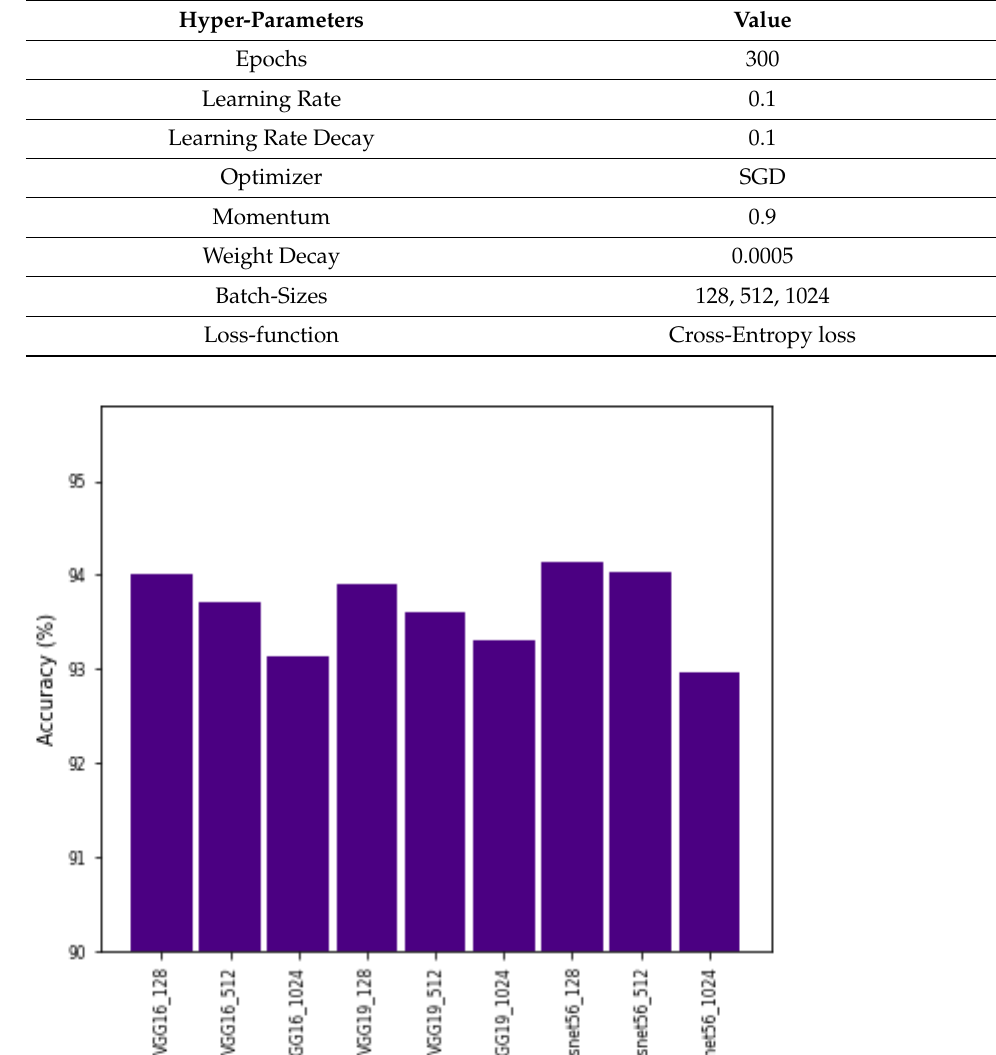
Table 4. Hyper-parameters for the models.